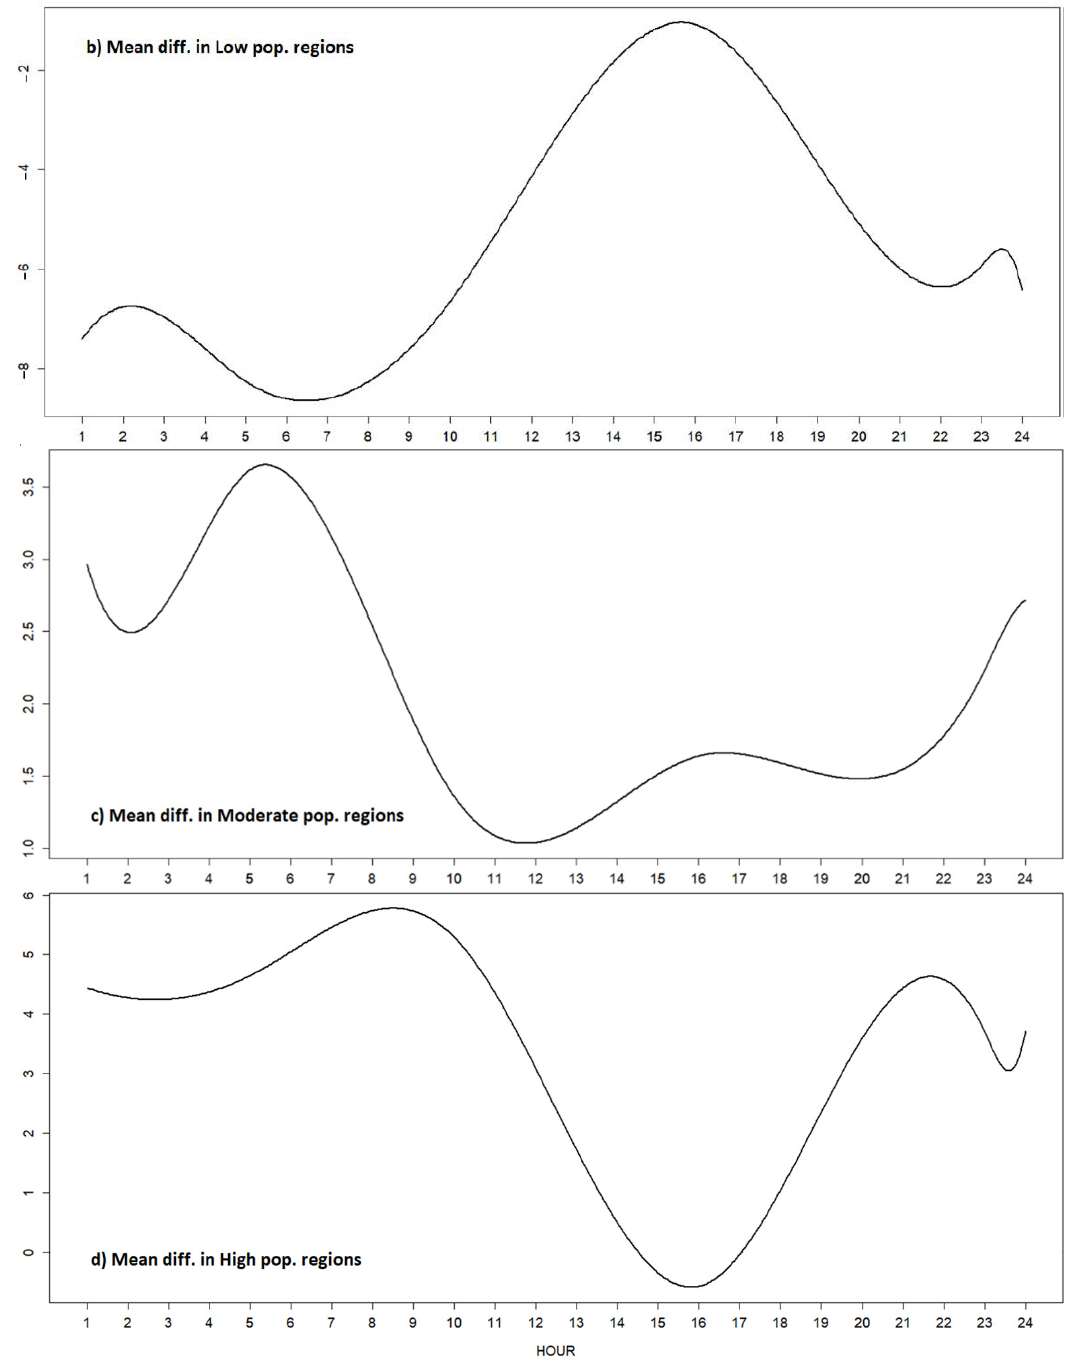
Figure 5. Comparison of the NO 2 diurnal curves in areas with low, moderate, and high population densities using FANOVA. ( a ) The grand mean of the NO 2 diurnal curves in Tehran. ( b ) Mean difference in regions with low population. ( c ) Mean difference in regions with moderate population. ( d ) Mean difference in regions with high population density, all values presented in ppb scale.